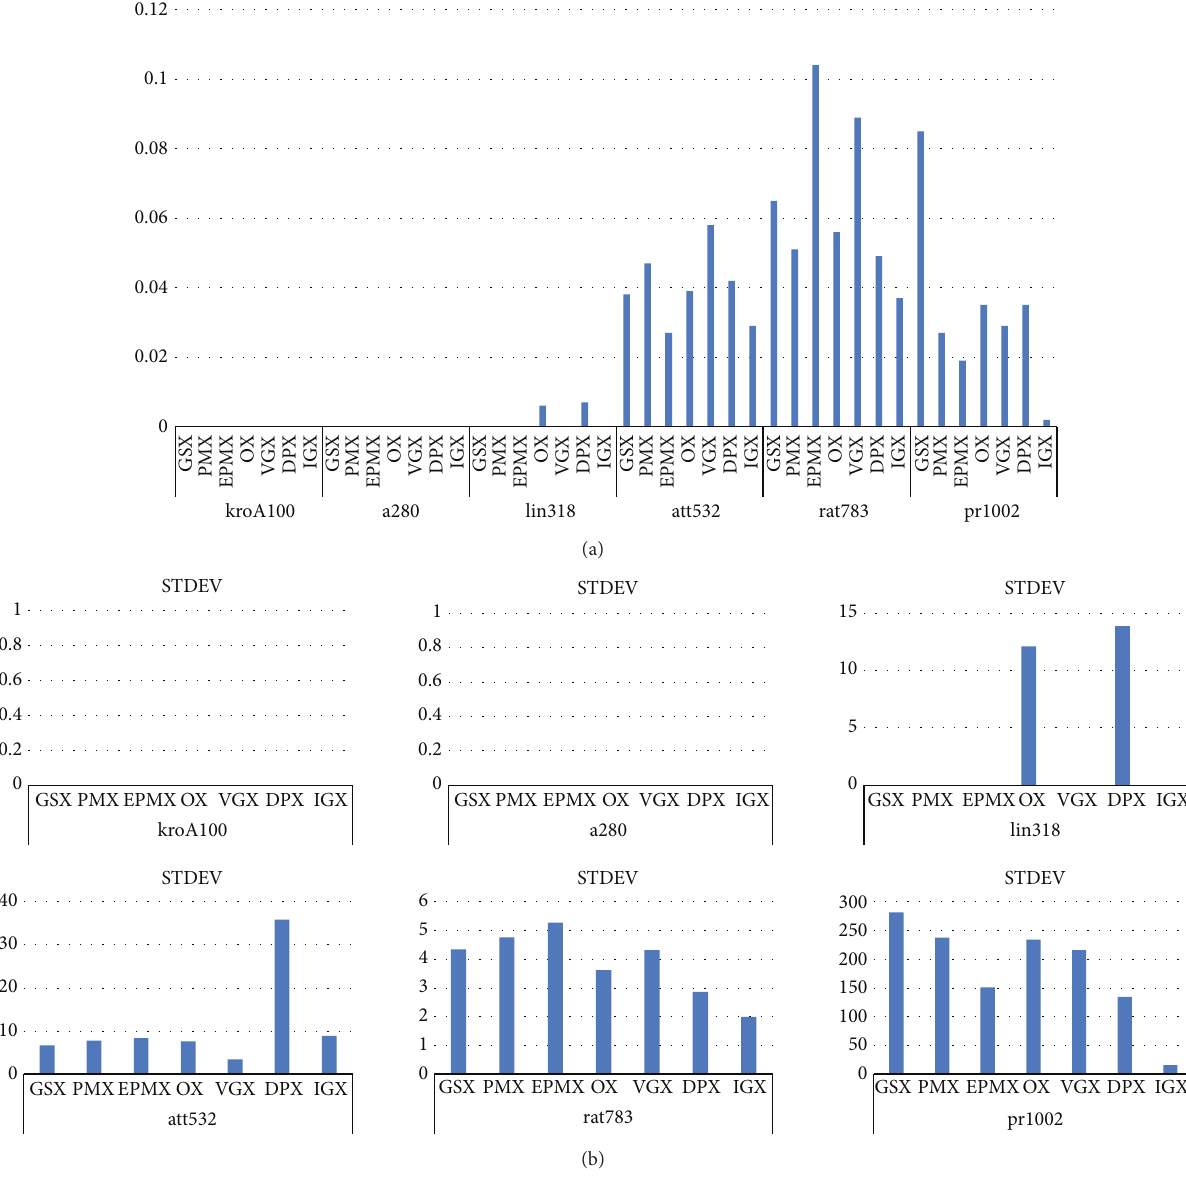
Figure 6: (a) Average percent and (b) standard